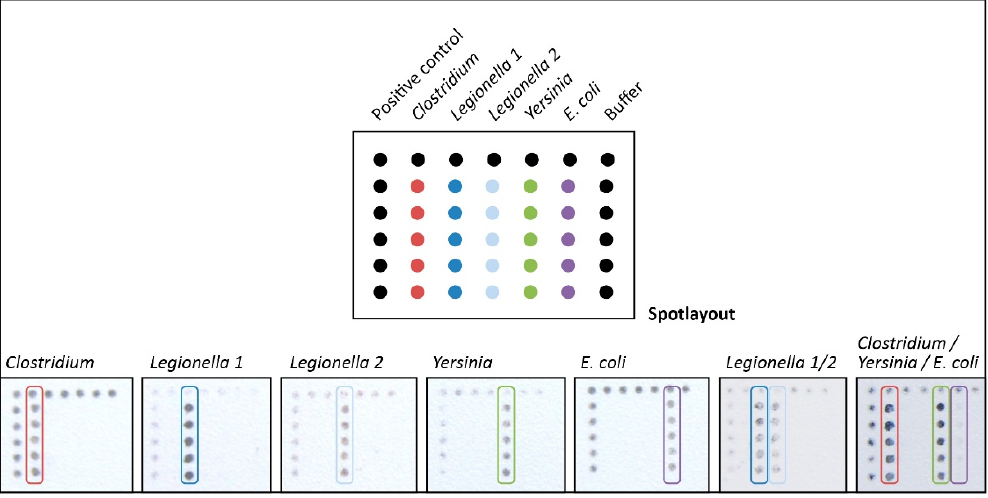
Figure 8. Specific on-chip detection of E. coli , Legionella and Yersinia using a combined protocol encompassing DNA hybridization and enzyme binding. DNA of the pathogens was amplified by classical PCR using isolated gDNA as a template. For on-chip hybridization experiments, PCR products were used singly and mixed.